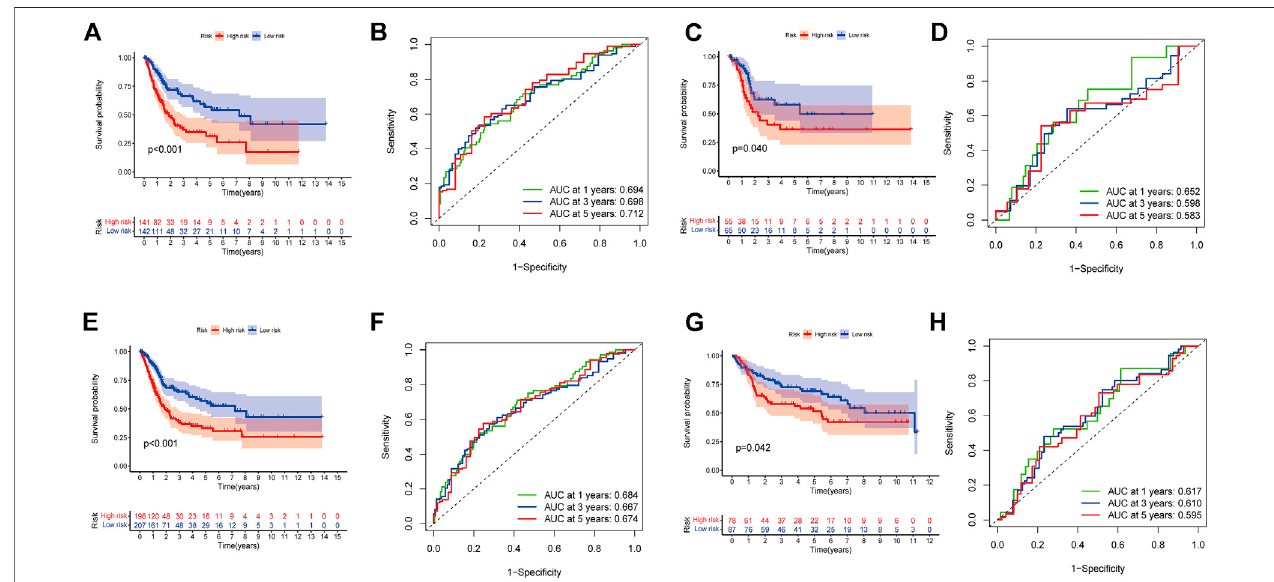
FIGURE 3 | Establishment of a prognostic risk model. (A) Group survival curves from the TCGA training cohort. (B) ROC curve for the TCGA training cohort. (C) Group survival curves from the TCGA testing cohort. (D) ROC curve for the TCGA testing cohort. (E) Group survival curves from the entire TCGA cohort. (F) ROC curve for the entire TCGA cohort. (G) Group survival curves from the GSE13507 cohort. (H) ROC curve for the GSE13507 cohort.